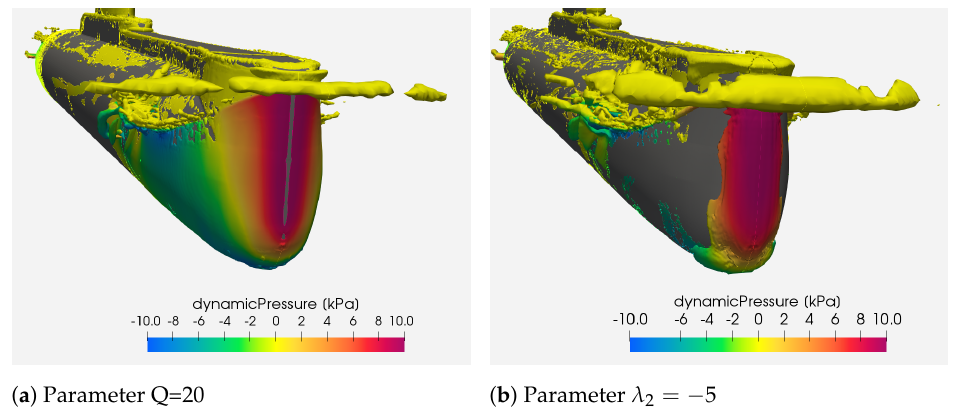
Figure 17. Vortex cores identification around the bow of a Type 209/1300 submarine at condition 1 and Fr =